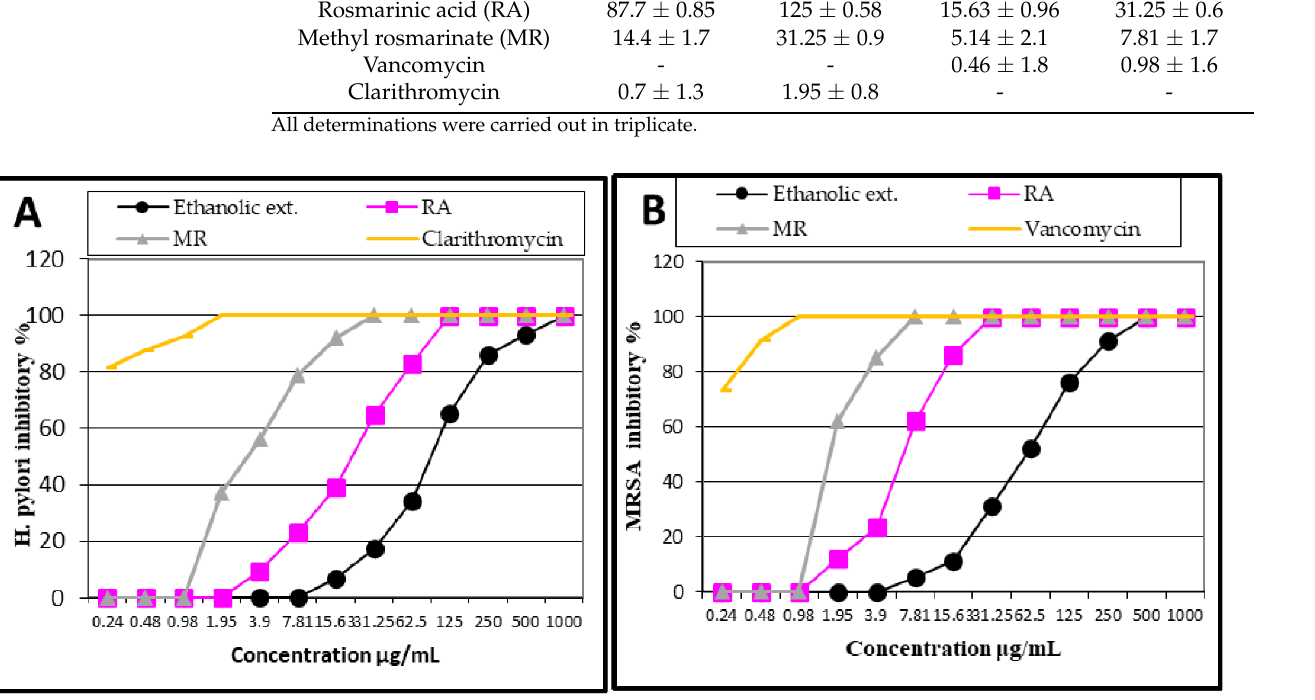
Figure 3. Dose response curves of stem bark ethanolic extract of Cordia africana , rosmarinic acid (RA), and methyl rosmarinate (MR) versus clarithromycin against ( A ): H. pylori and vancomycin against ( B ): methicillin-resistant Staphylococcus aureus (MRSA).